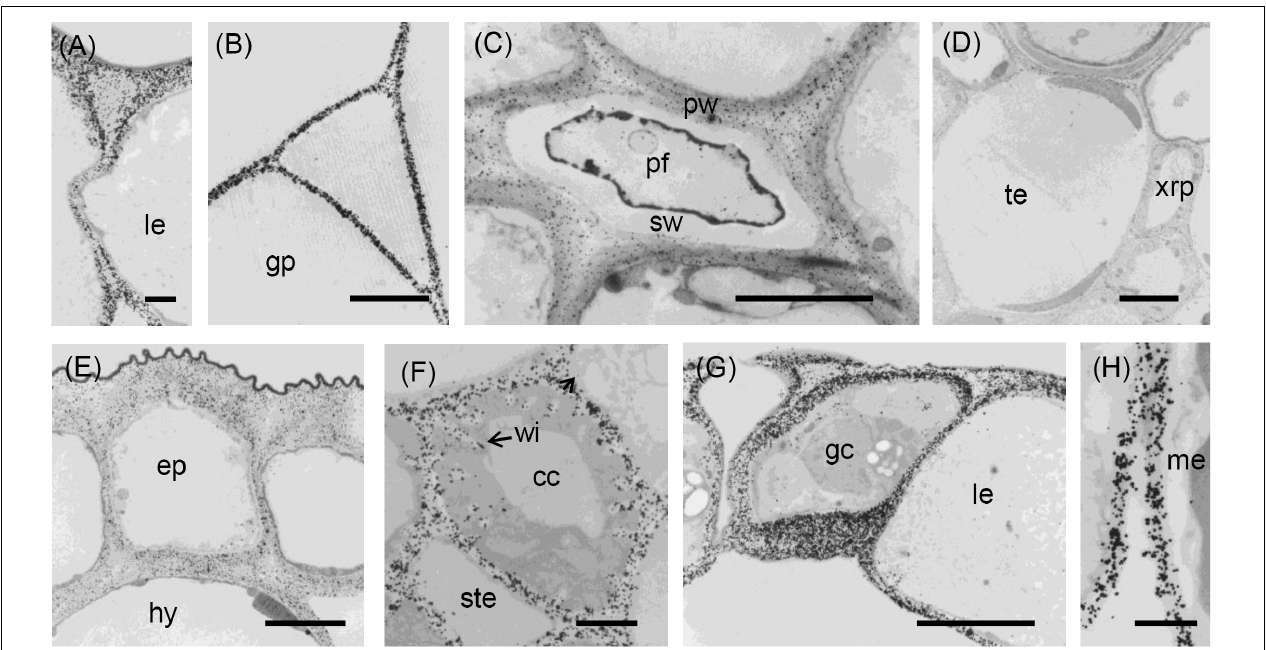
FIGURE 5 | Transmission electron micrographs of transverse sections cut from a rosette leaf of an 8-week-old chicory plant and immunogold labelled with JIM7. (A) A lamina epidermal cell, showing the walls evenly labelled. (B) A ground parenchyma cell in the midrib, showing labelling throughout the walls but less intense at the corners of cell junctions. (C) A phloem fibre, showing labelling in the primary walls but no labelling in the secondary walls. (D) The xylem in the midrib, showing labelling in the primary walls of the tracheary elements and xylem ray parenchyma cells but no labelling in the secondary walls of the tracheary elements. (E) Epidermal and hypodermal cells, showing even labelling of the walls. (F) Transfer cells in a minor vein of the lamina, showing labelling of transfer cell walls and wall ingrowths. (G) Stomatal guard cells, showing dense, but non-uniform labelling of the guard cell walls, with labelling also present in the cuticular layer. (H) Mesophyll cells, showing no labelling at the corners of intercellular spaces. cc: transfer cell; gp: ground parenchyma; ep: epidermal cell; gc: stomatal guard cell; hy: hypodermis; le: lamina epidermis; me: mesophyll; pf: phloem fibre; pw: primary wall; sw: secondary wall; te: tracheary element; xrp: xylem ray parenchyma; and wi: wall ingrowth. Bars: (A,F,H) 1 µ m; (B–E,G) 5 µ